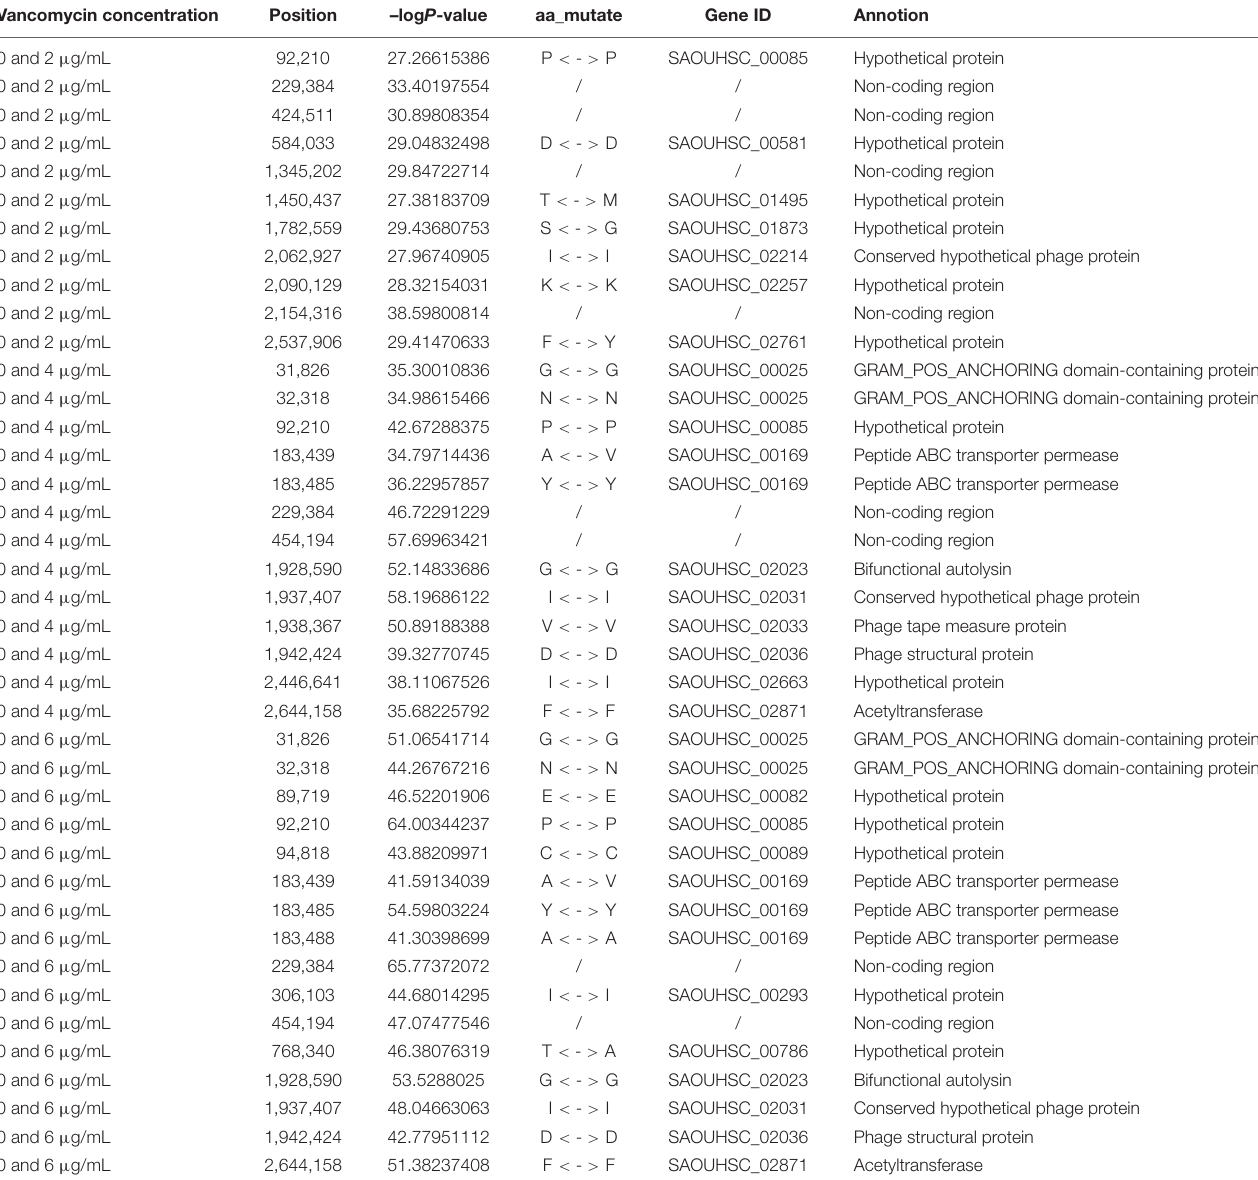
TABLE 2 | Gene annotation of significant sites in bivariate functional mapping. Vancomycin